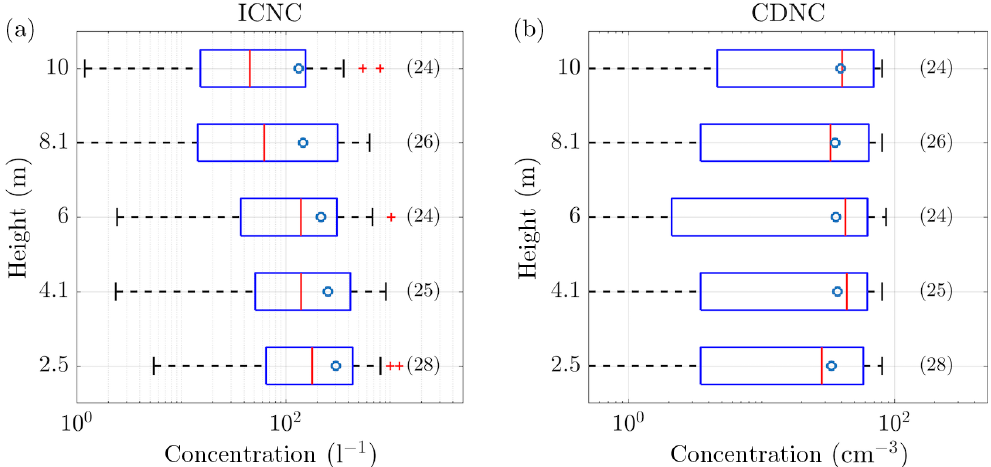
Figure 6. ICNC (a) and CDNC (b) as a function of the height of the elevator at the meteorological tower of the SBO. This plot is a summary of the 24 profiles obtained on 4 February 2017. The data were averaged for each height over the entire time period. In brackets are the number of measurements per height. For each box, the central line marks the median value of the measurement and the left and right edges of the box represent the 25th and the 75th percentiles, respectively. The whiskers extend to the minima and maxima of the data; outliers are marked as red pluses. The mean values of the measurements are indicated as blue circles. Table 1. Summary of important features of the ICNC profiles observed on 4 February (Fig. 7) and 17 February (Fig. 10) 2017. ICNC max refers to the observed maximum of the mean ICNC over height. ICNC 10 refers to the average ICNC at 10m. Time Height of Processes interval ICNC max ICNC max ICNC 10 involved (UTC) (m) (l − 1 ) (l − 1 ) from Fig. 16 4 February